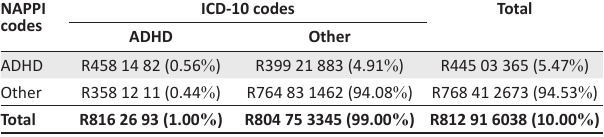
TABLE 2: The cost of adult ADHD according to claim